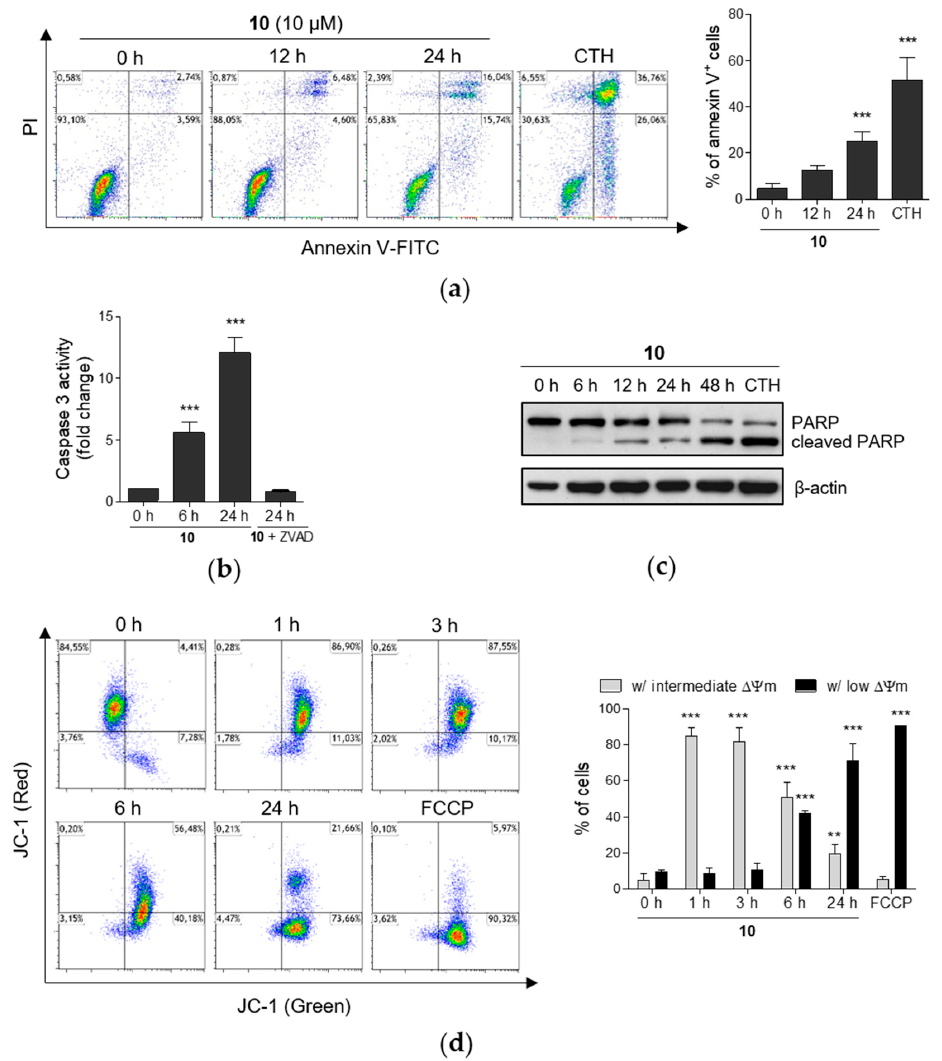
Figure 3. Compound 10 induces apoptosis in THP-1 cells. The same concentration of compound 10 (10 µM) was used for all experiments. ( a ) Cells were incubated with compound 10 for 12 h and 24 h, stained by annexin V-FITC conjugate and propidium iodide (PI) and analyzed by flow cytometry. Cells cultured with camptothecin (CTH, 5 µM) for 24 h were used as positive control. Representative flow cytometry plots are shown. ( b ) After the incubation of cells with compound 10 , cell lysates were prepared and incubated with caspase 3 substrate Z-DEVD-R 110 and the fluorescence was measured. Cells pretreated with pan caspase inhibitor Z-VAD-FMK (ZVAD) for 30 min before the incubation with 10 were used as negative control. ( c ) The levels of PARP and cleaved PARP were detected by immunoblot analysis. Sample treated by 5 µM of camptothecin (CTH) for 24 h was used as positive control. ( d ) THP-1 cells were stained with JC-1 fluorescent probe and the changes of the mitochondrial membrane potential ( ΔΨ m) were analyzed by flow cytometry. Cells treated by FCCP for 30 min were considered as positive control sample. Cell subsets with high red and green fluorescence were identified as the cells with intermediate MMP, cell subsets with low red, but high green fluorescence were determined as the cells with low MMP as shown in representative flow cytometry plots. The results are shown as the mean ± SD from at least three independent experiments. ** p < 0.01, *** p < 0.001, significantly different from 0